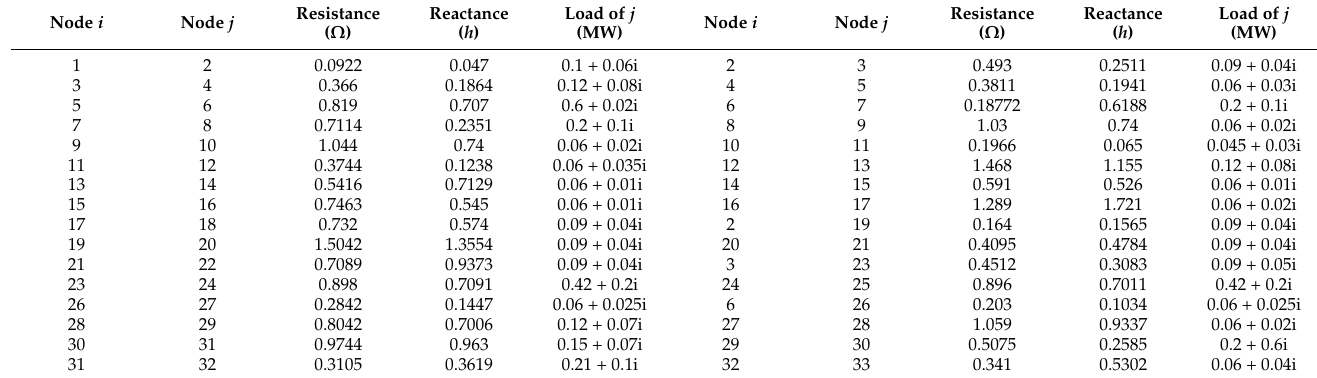
Table 4. Parameters of microgrid 1.